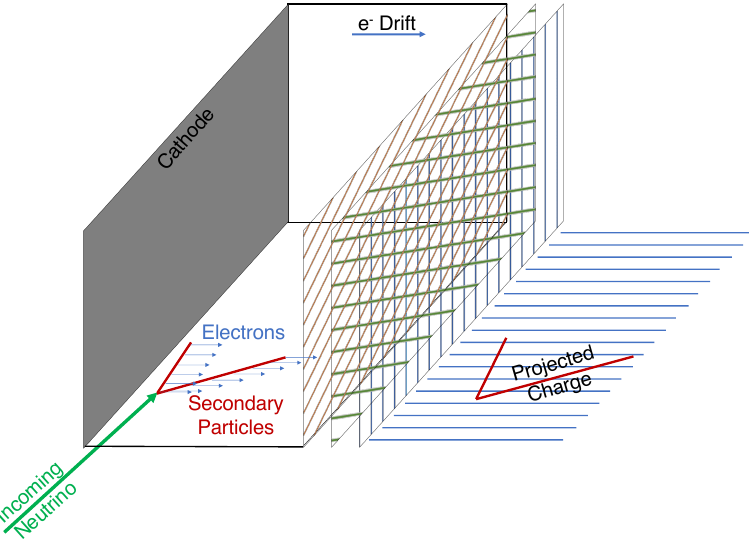
Figure 1. Operational principle of a generic LArTPC.